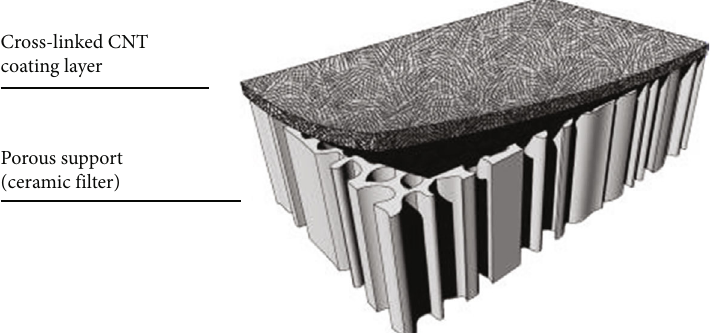
Figure 3: Hybrid CNT fi lter schematic illustration. Cross-linked CNT fi ltration on a porous ceramic substrate forms the basis of a durable water puri fi cation system that is also